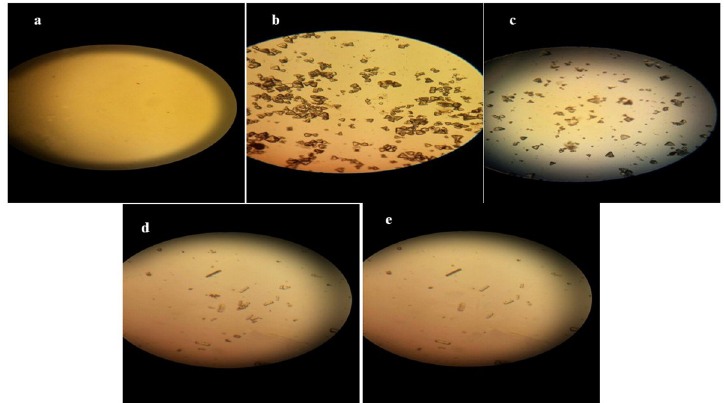
Fig 1. Microscopic examination of urine samples (X200). (A) NC group (B) EG group (C) CYS group (D) STS group (E) CAND group. NC group: Rats received water; EG group: (1% ethylene glycol in drinking water for 28 days); CYS group: (EG + 750 mg/kg CYS, orally, once daily); STS group: (EG + 0.4 g/kg STS, i.p., 3 times/week); CAND group: (EG + 70 μ g/ml CAND in drinking water). Treatments were administered simultaneously with EG drinking water for 28